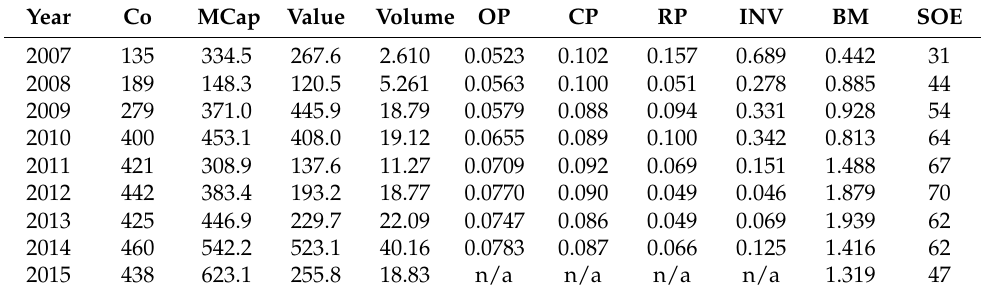
Table 1. Sample coverage for the Vietnamese stock market. Co is the number of listed companies during a year. MCap is market capitalization in trillions of Vietnamese Dong (VND) as at the end of a year. Value and Volume are the annual trading value (in trillions of VND) and trading volume (in millions of shares) of all stocks. OP, CP and RP are the average value of operating profitability ratio, cash profitability ratio and ROE profitability ratio per stock, respectively, using Fama and French (2015, 2018, 2020), Ball et al. (2015) and Hou et al. (2019) profitability definitions. INV is the average investment ratio per stock, respectively, as defined using Fama and French (2015) methodology. BM is the average book-to-market ratio per stock. SOE is the number of listed companies that have state share of ownership. Data were obtained from Datastream from July 2007 to August